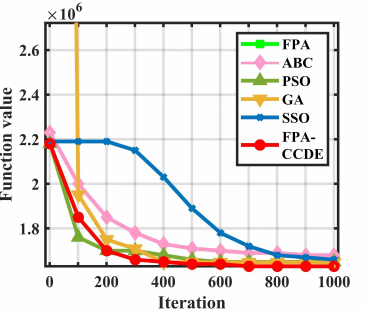
Figure 6. Partial enlargement of the objective function convergence curve.